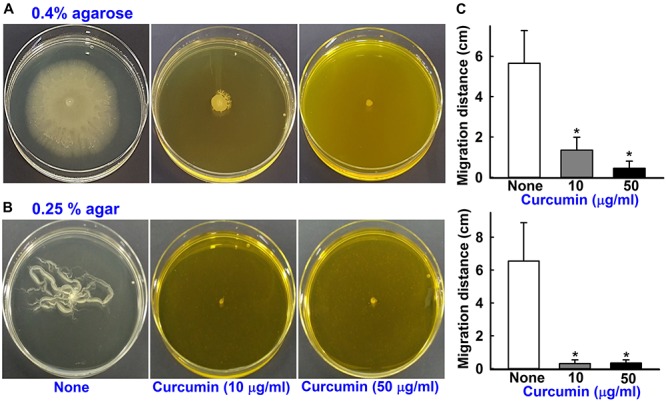
Effects of curcumin on motility. The surface motilities on 0.4% agarose (A) and 0.25% agar (B) of A. baumannii ATCC 17978 were investigated after adding curcumin at 10 or 50 μg/ml to motility agar. The bar graphs represent swimming and swarming motility diameters in cm in the presence and absence of curcumin (C). *p < 0.05 versus untreated controls.